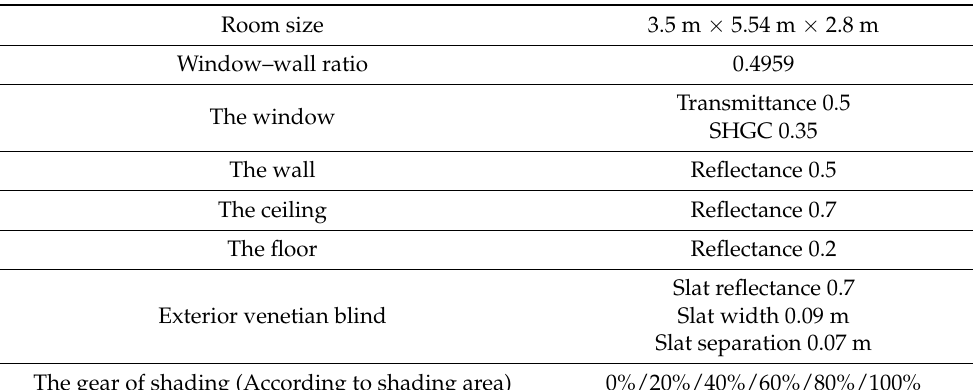
Table 5. Summary of room parameters in case 2.